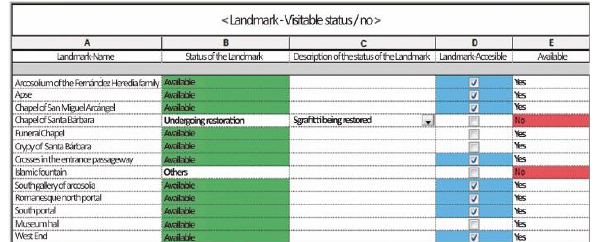
Figure 4. Table showing the availability of tourist landmarks for visits. Source: Authors’ own